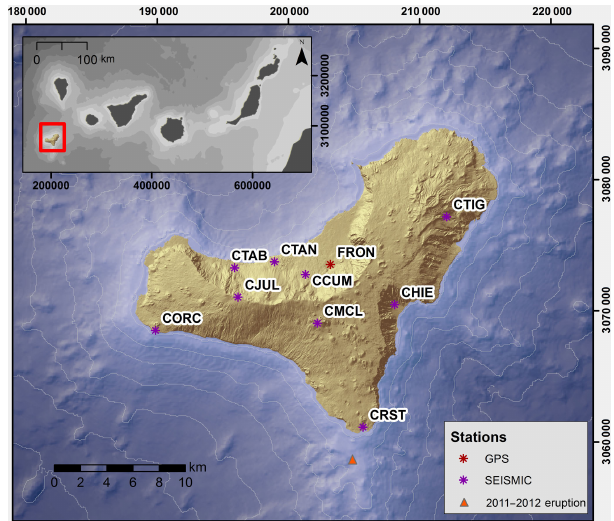
Figure 1. IGN monitoring network during the unrest period at El Hierro. The top left inset displays the location of El Hierro within the Canary